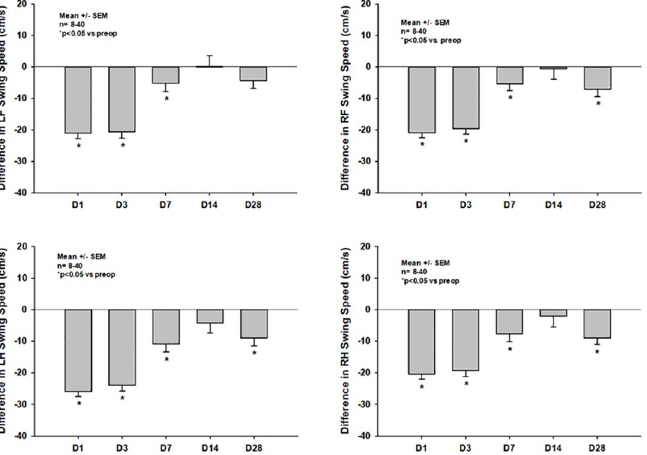
Fig 6. Differences in swing speed of the four single paws compared to pretrauma status on days one thru 28 after CCI.